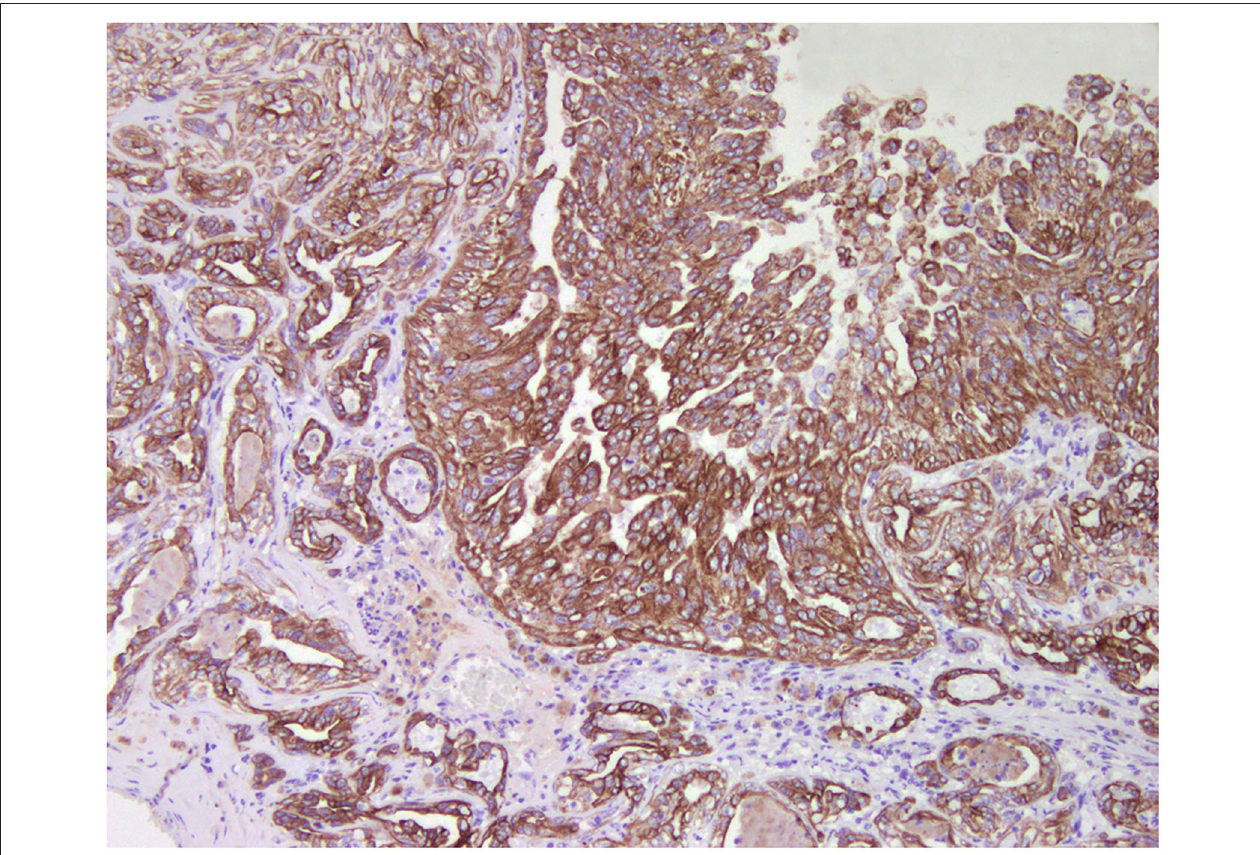
FIGURE 1 | Tubulo-papillary carcinoma, mammary gland, dog. Immunohistochemical cytoplasmic staining of wide-spectrum cytokeratins ( AE1 / AE3 ). Luminal and basal/myoepithelial cells are positive ( brown